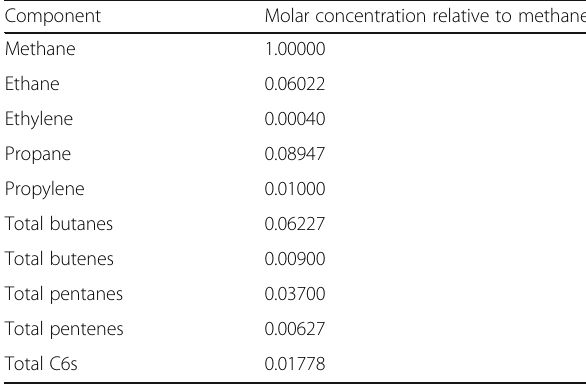
Table 1 GC analysis of aqueous phase, Aq1